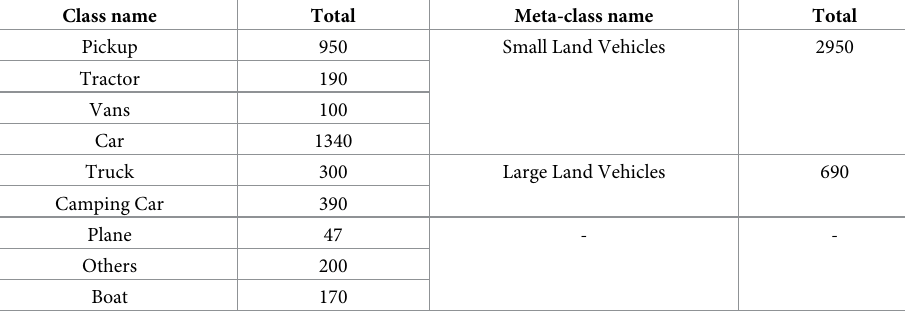
Table 5. VEDAI dataset categories